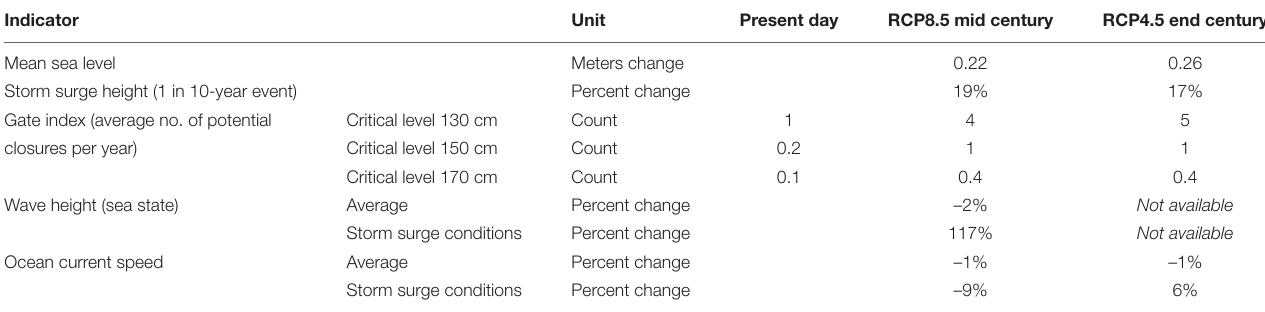
TABLE 5 | Climate change indicators for the Copenhagen use case for the RCP8.5 mid-century (2041–2070) and RCP 4.5 end-century (2071–2100) periods relative to the present day